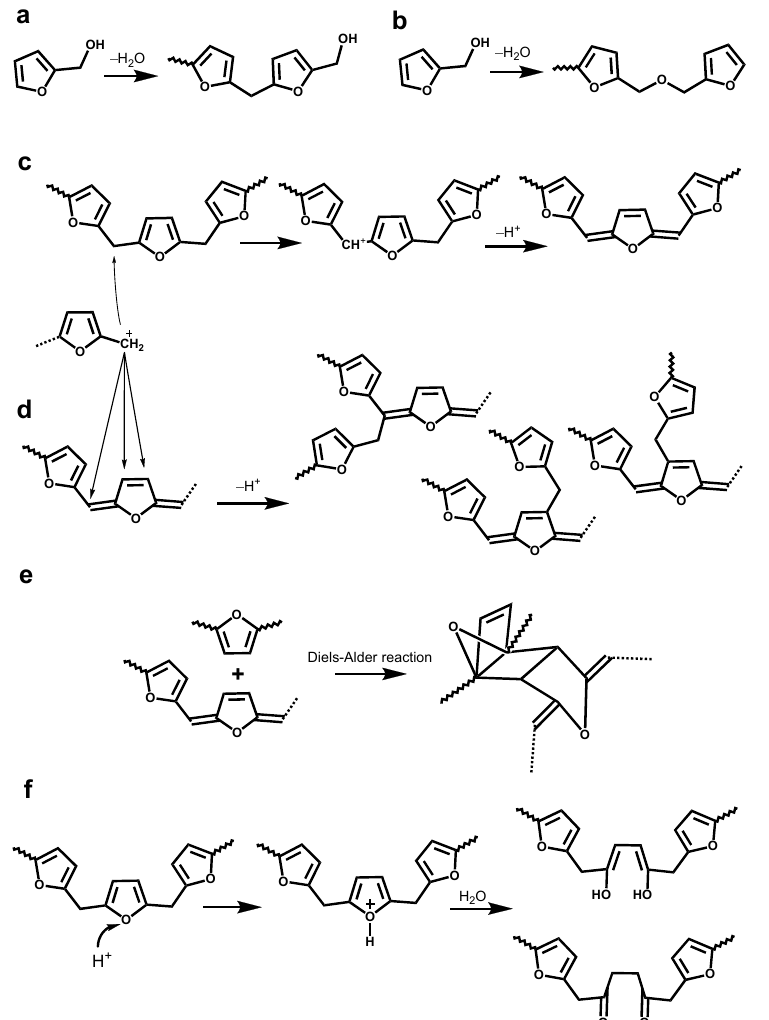
Figure 1. Different pathways for the self-polymerization of furfuryl alcohol: ( a ) formation of methylene linkage; ( b ) formation of dimethyl ether linkage; ( c ) formation of conjugated double-bond sequences; ( d ) formation of branching linkage; ( e ) Diels-Alder cycloaddition reaction; ( f ) formation of γ‐ diketone structures18 ‐ 20.